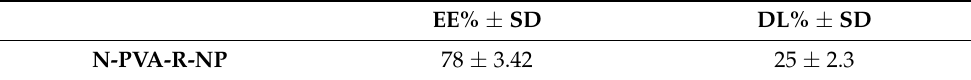
Table 2. EE% and DL% value of N-PVA-R-NP